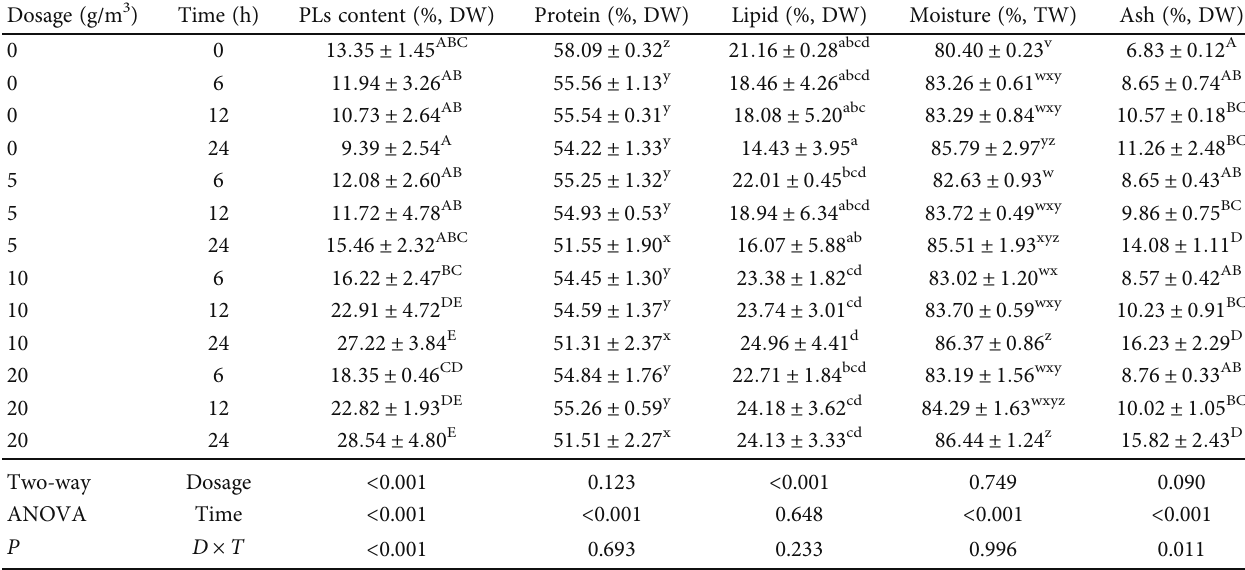
Table 1: Proximate nutrient composition analysis of Artemia nauplii enriched with soybean lecithin for di ff erent durations and di ff erent dosages.